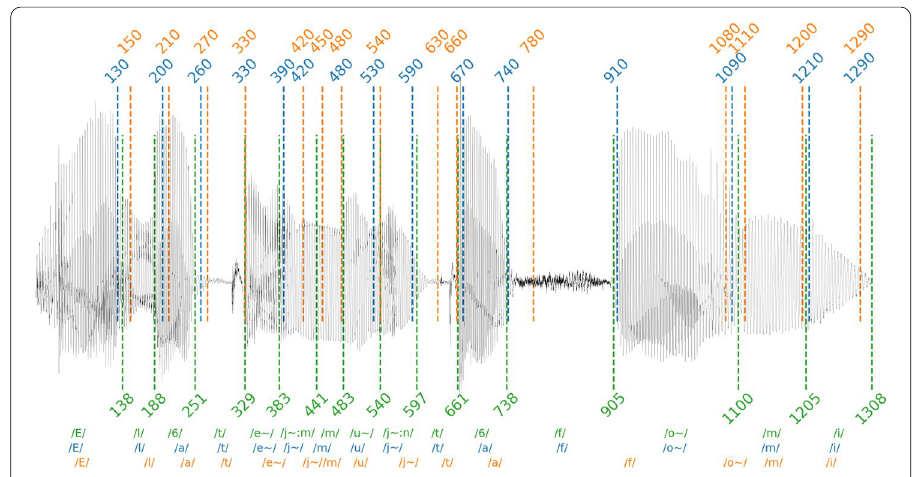
Fig. 9 Example of alignments for the utterance “ ela tem muita fome .” Ground-truth boundaries are shown in green, while automatic ones produced by Kaldi’s monophone- and TDNN-F-based models are shown in blue and orange, respectively. Tokens (phonemes) are shown at the bottom at their respective in-between-boundaries middle position. Notice that phonemes /j ∼ : m/ and /j ∼ : n/ have been created in the ground-truth through a merge of the individual phones /j ∼ , /m/ and /n/ , based on M2M mappings